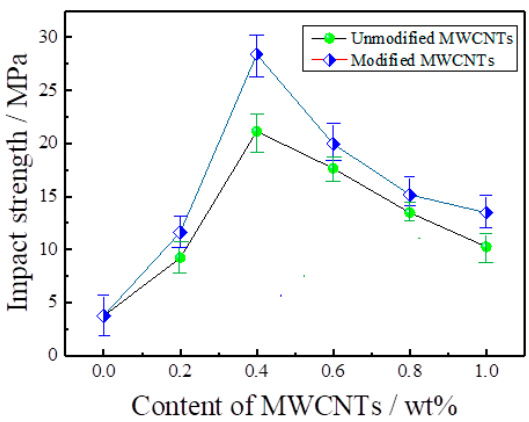
Figure 11. The impact strength of epoxy composites with the content of various PABA-modified MWCNTs.